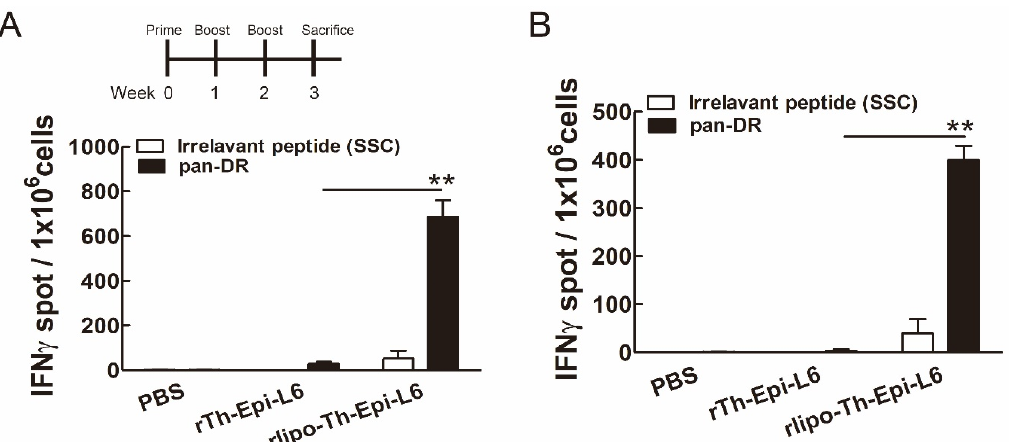
Figure 6. Immunization with rlipo-Th-Epi-L6 induced higher levels of pan-DR-specific IFN- γ -secreting cells. ( A , B ) The immunization schedule in C57BL / 6 mice by injecting indicated recombinant proteins 3 times at 1-week intervals. n = 6, each group. ( A ) Splenocytes (5 × 10 5 cells / well) or ( B ) lymph node cells (2 × 10 5 cells / well) from immunized mice were incubated with irrelevant control peptide (SSC) or pan-DR peptides for 48 h in an anti-IFN- γ -coated 96-well ELISPOT plate. The IFN- γ spots were measured using an ELISPOT reader. Bars and error bars show the mean ± SEM. ** p < 0.01 by t -test.